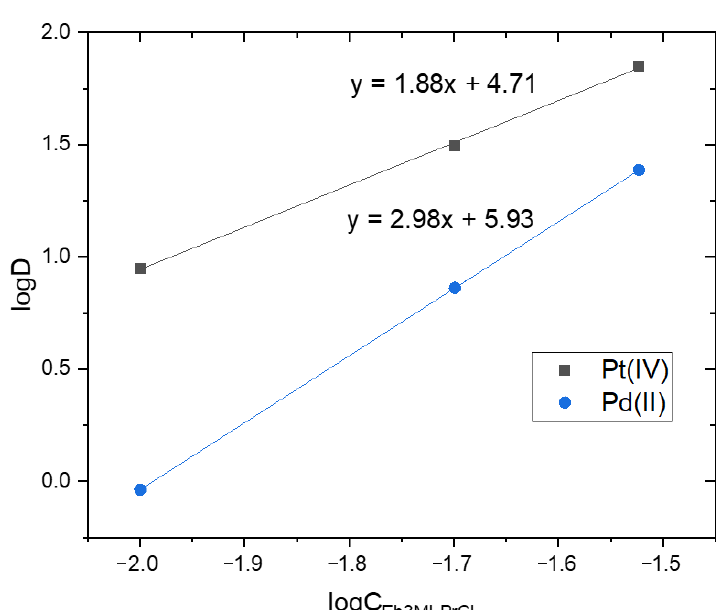
Figure 4. Plots of log D vs. logC Eh3MI-PrCl for Pt(IV) and Pd(II) extraction from two-component feed (A/O = 1, 20 min, feed: 1.25 × 10 − 3 M Pd(II), 1.25 × 10 − 3 M Pt(IV) in 1 M HCl, organics: 1 – 3 × 10 − 2 M Eh3MI-PrCl in toluene).